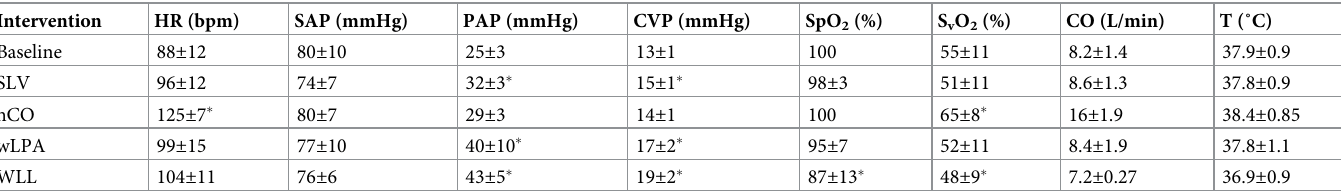
Table 2. Hemodynamic parameters. Intervention